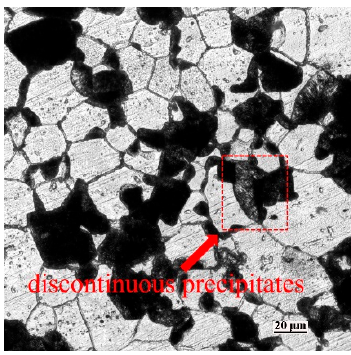
Figure 2. The microstructure (LM) of the extruded AZ80 alloy aged for 160 min.